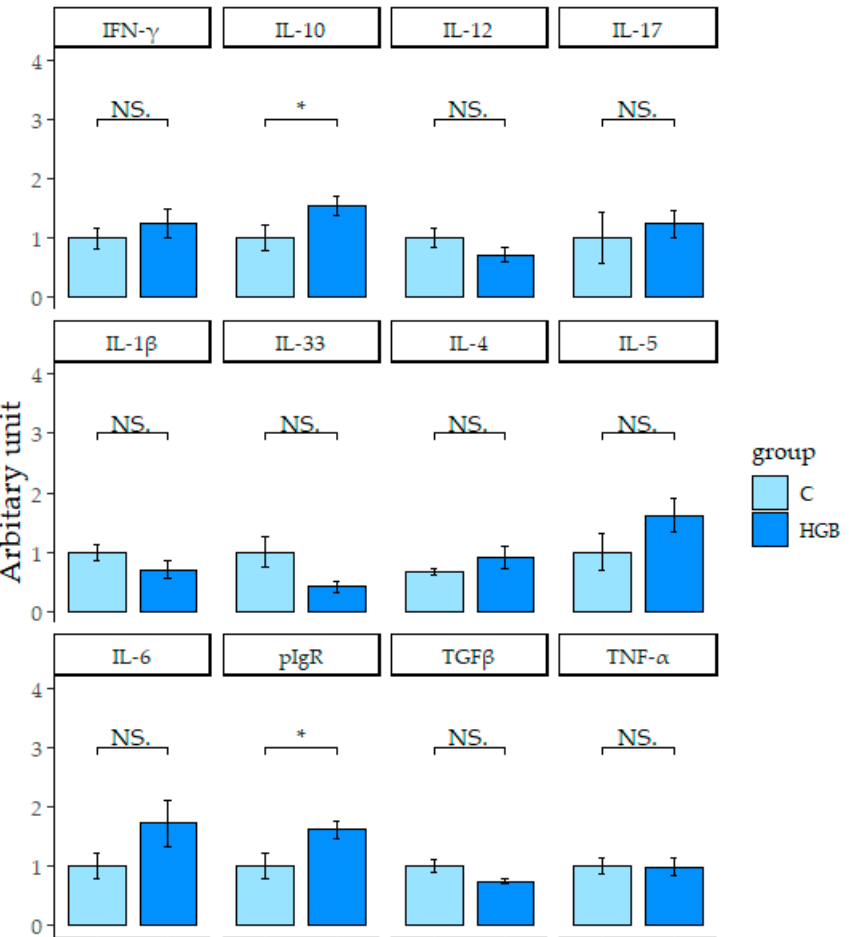
Figure 3. The expression levels of mRNA in the ileum. Values are means ± SE, n = 8. * p < 0.05 indicates a significant difference between each group, “NS” is not significant. C: control group, HGB: high β -glucan barley group. IFN- γ , interferon gamma; IL-10 , interleukin 10; IL-12 , interleukin 12; IL-17 , interleukin 17; IL-1 β , interleukin 1 beta; IL-33 , interleukin 33; IL-4 , interleukin 4; IL-5 , inter- leukin 5; IL-6 , interleukin 6; pIgR , polymeric immunoglobulin receptor; TGF β , transforming growth factor beta; TNF- α , tumor necrosis factor- α .